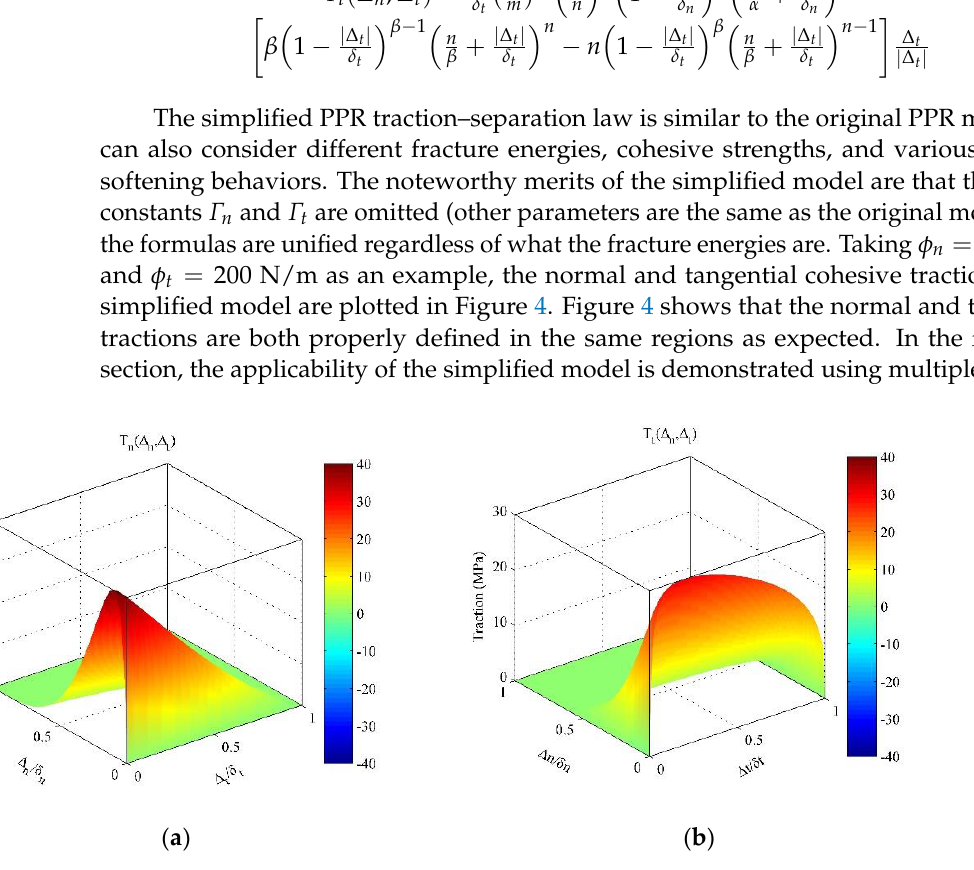
Figure 4. The cohesive tractions with 𝜙 𝑛 = 100 N/m , 𝜙 𝑡 = 200 N/m , 𝜎 𝑚𝑎𝑥 = 40 MPa , 𝜏 𝑚𝑎𝑥 = 30 MPa , 𝛼 = 5 , 𝛽 = 1.3 , 𝜆 𝑛 = 0.1 , and 𝜆 𝑡 = 0.2 . Normal traction ( a ); tangential traction ( b ).